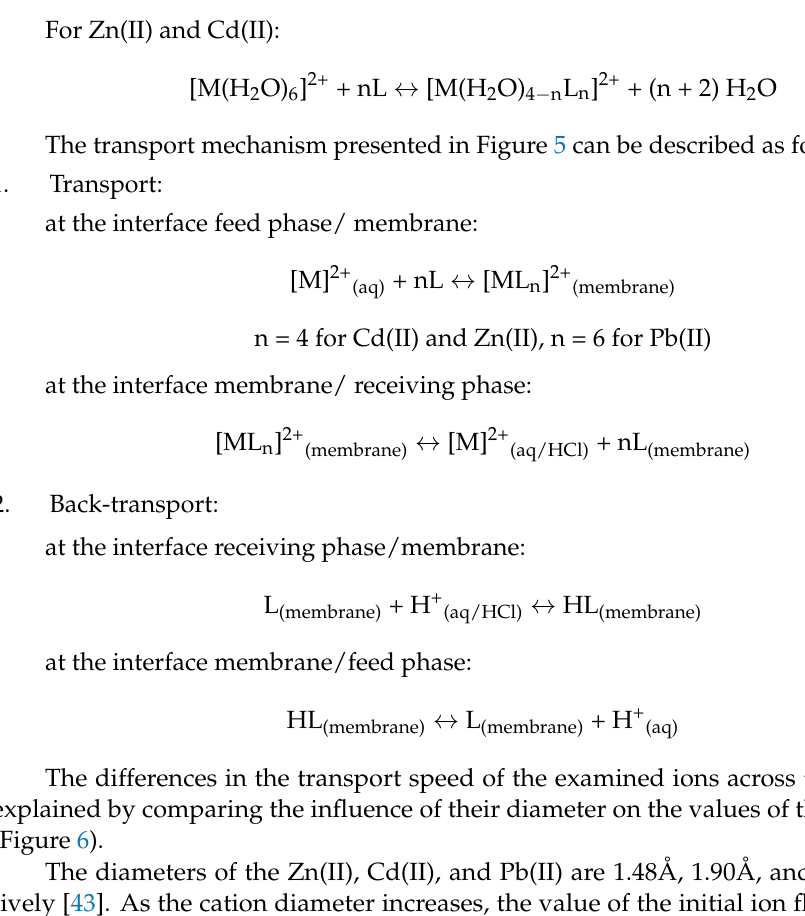
Figure 5. Schematic transport of metal ions across PIMs with